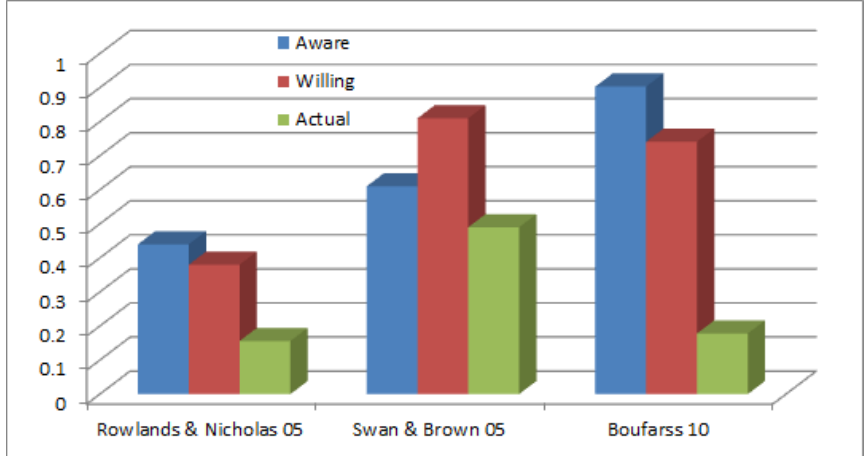
Figure 3. The divide between awareness and action for open access self-archiving